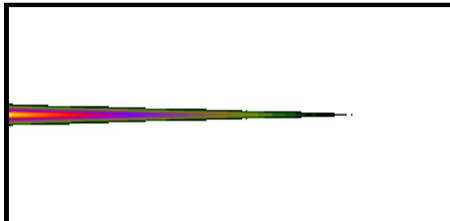
Figure 16. Plot between the propagation length and power loss for the total counterpropagating HE 9,806.2454